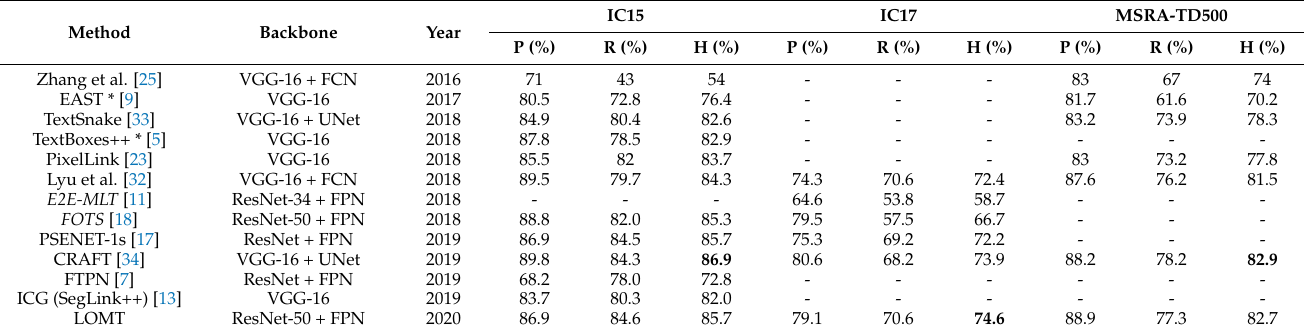
Table 1. Results on quadrilateral-type datasets, such as IC15, IC17 and TD500. P, R and H refer to the precision, recall rate and H-mean, respectively. The best H score is highlighted in bold, and * denotes that the results based on multiscale tests. Method Backbone Zhang et al.